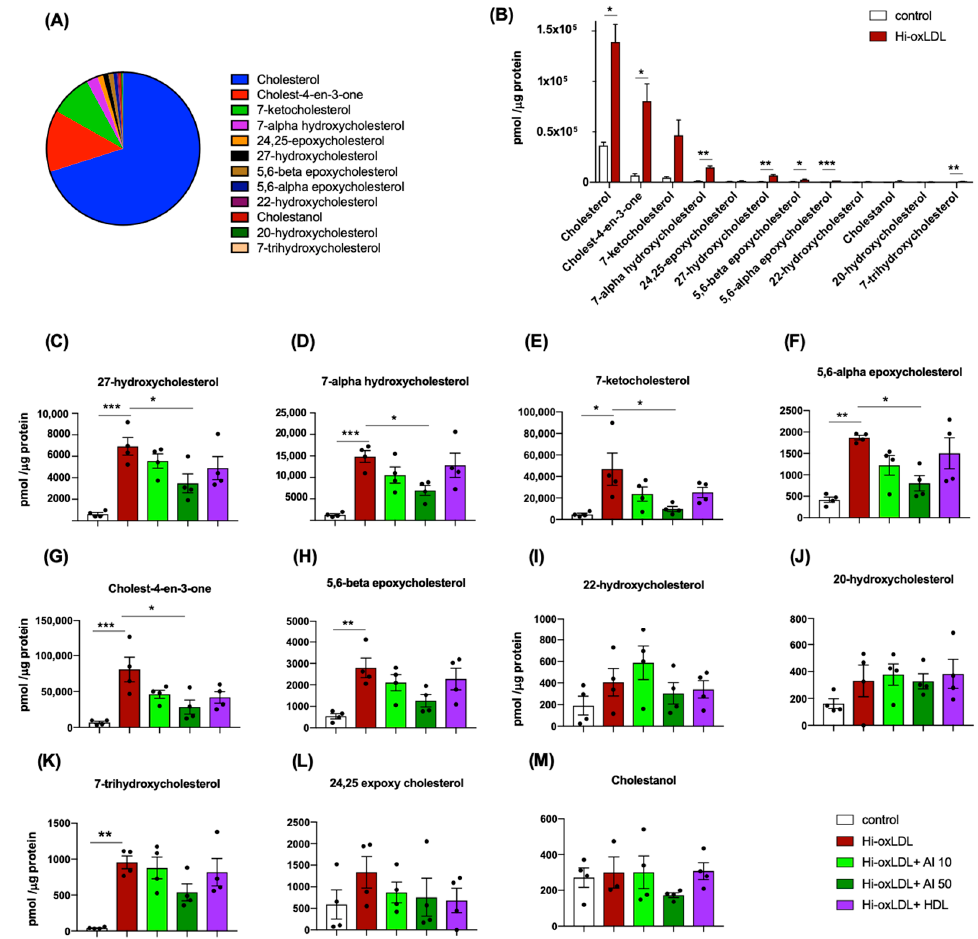
Figure 4. Targeted sterol lipidomics. ( A ) Relative levels of 12 sterols were presented based on their % of abundance to total sterols detected in untreated MPMs. ( B ) Increased levels of oxysterols upon hi-oxLDL loading were presented as abundance ( C–M ) Abundance of individual sterol species with apoA-I and HDL treatments. The abundance of lipids in ( B – M ) was calculated by pmol of lipid normalized to µ g of protein. The data were presented as mean ± SEM ( n = 4 per group). * p < 0.05, ** p < 0.05, *** p < 0.0005.